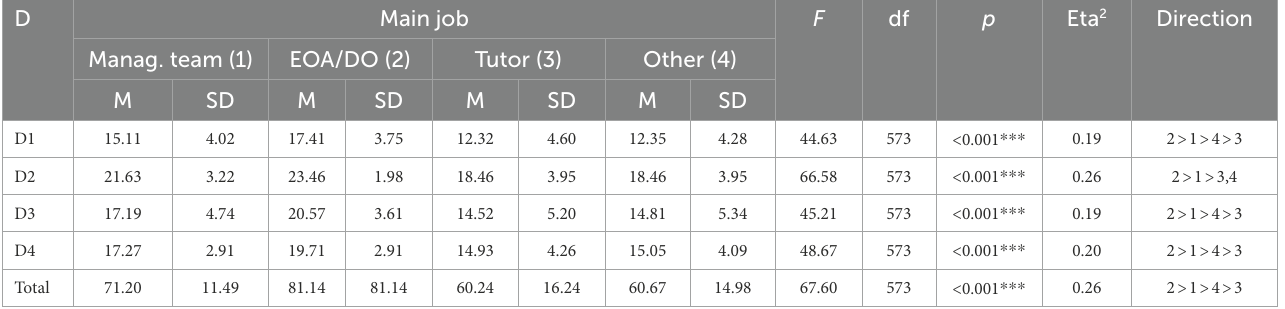
TABLE 5 ANOVA based on the variable main job